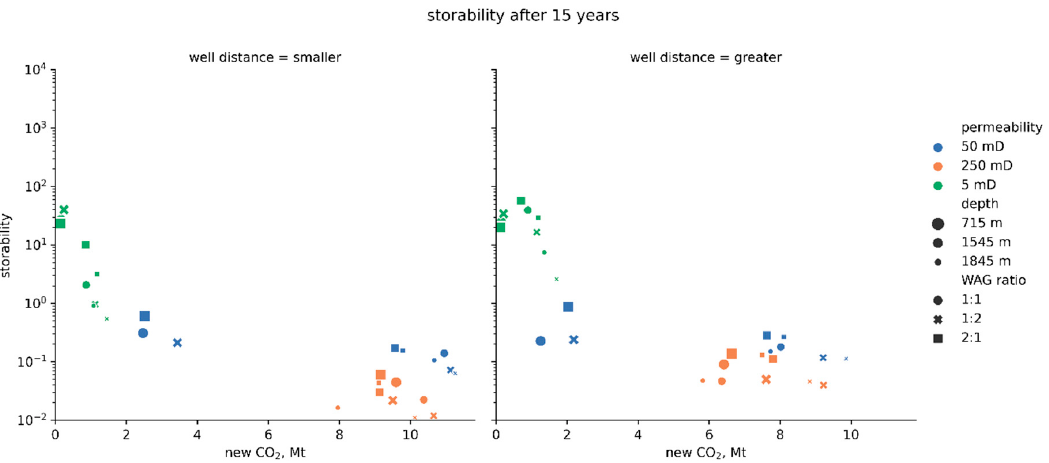
Figure 9. Storability versus new CO 2 after 15 years of EOR.